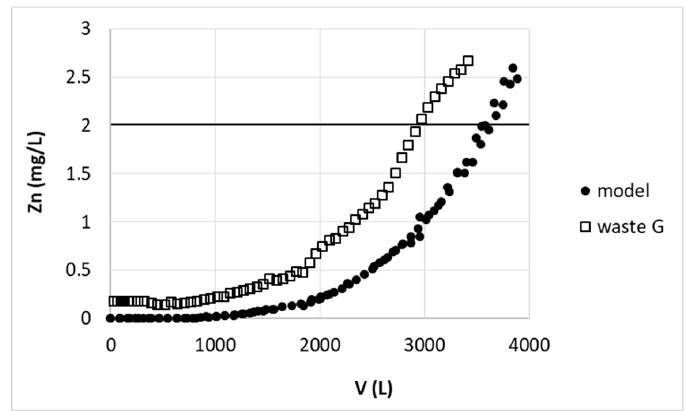
Figure 12. Comparison of zinc(II) ions removal from model solution (model) and galvanizing plant wastewater (waste G) on hybrid pectin-based biosorbent. Mass of sorbent (dry form, large grain): 16 kg; flow rate: 200 L/h; initial concentration of Zn: 30 mg/L; pH = 6.